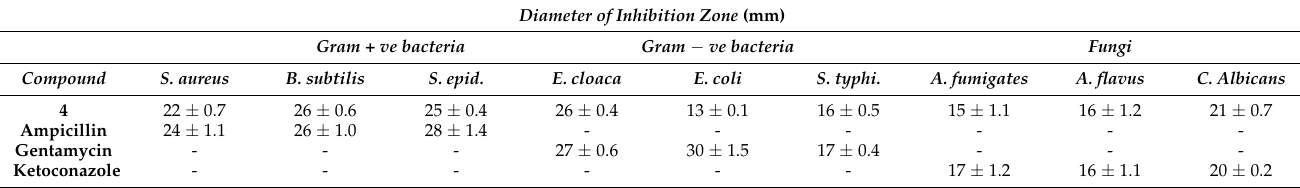
Table 3. Antimicrobial screening for compound 4 .